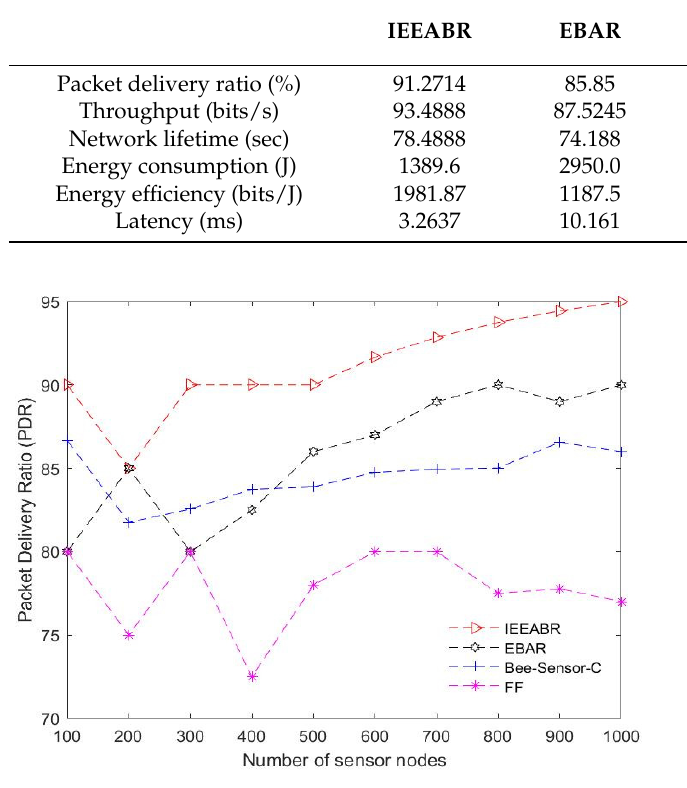
Figure 14. Comparison based on the packet delivery ratio.